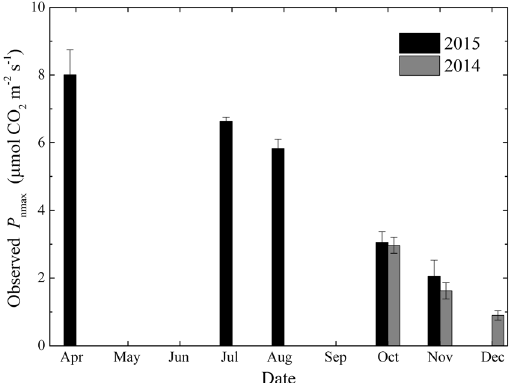
Figure 2. Observed monthly mean maximum rates of net photosynthesis ( P nmax , means ± SE) calculated from the P n - I curves during the measurement period from October 2014 to November 2015.